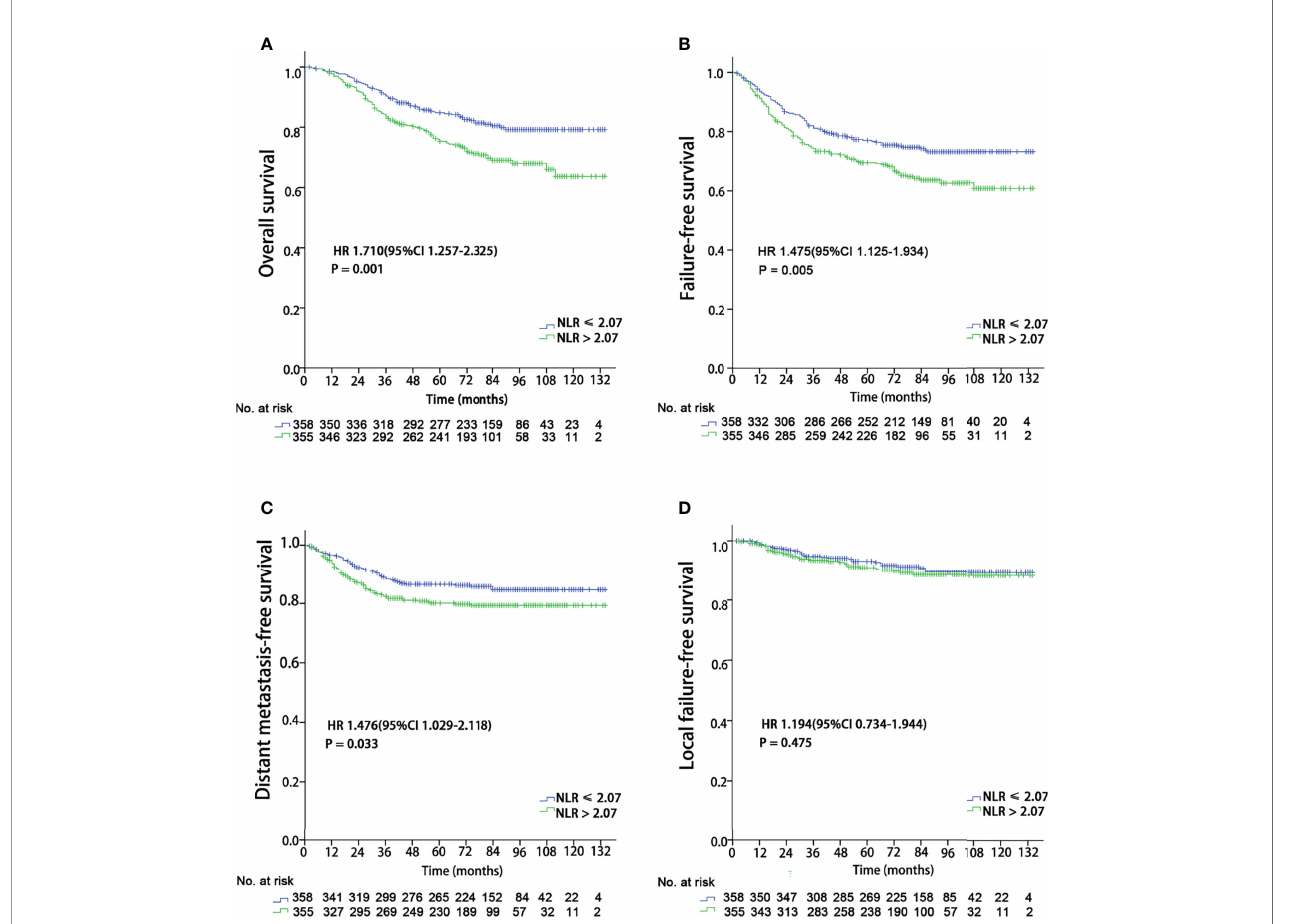
FIGURE 1 | Kaplan – Meier survival curves for 713 patients strati fi ed by the cutoff of NLR. NLR, Neutrophil-to-lymphocyte ratio. (A) Overall survival; (B) Failure-free survival; (C) Distant metastasis failure-free survival; (D) Local failure-free survival.